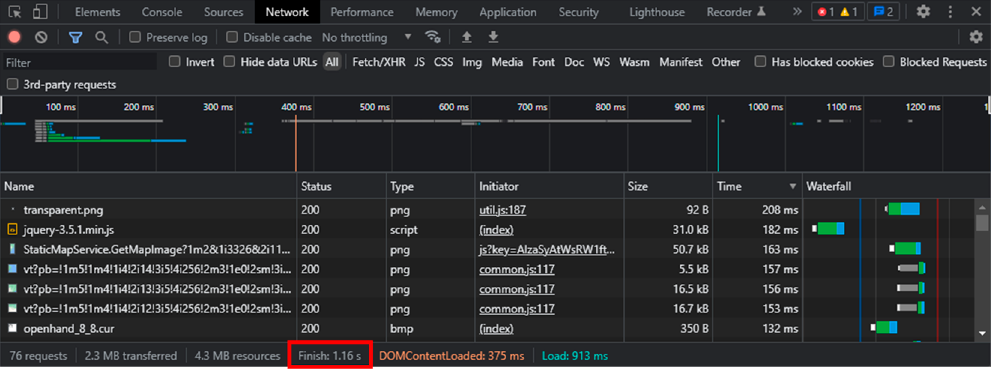
Figure 14. Measuring Inquiry (complex) Response Time in Browser Developer Tools Network Tab. Table 10. Response Time for each CyCOP Visualization.